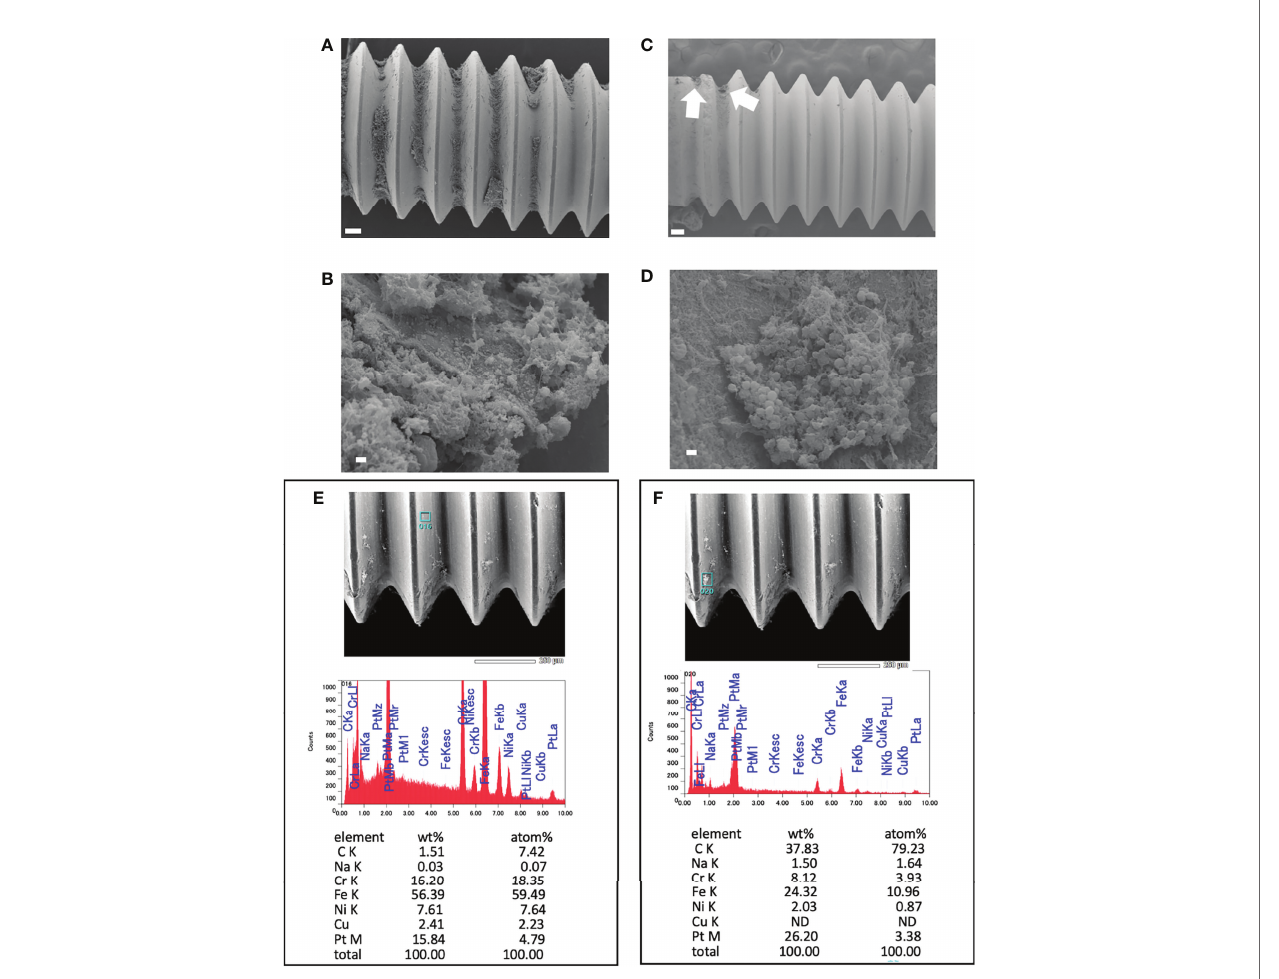
FIGURE 4 | Scanning electron microscopy (SEM) image of USA300LAC infected implant of day 14 in vivo bio fi lm. (A, B) are images after 24 h of antibiotics treatment with 512 µg/mL gentamicin which showed robust bio fi lm formation in the screw grooves. (C, D) are images after vortex-sonication-vortex method (VSVM) which has a fare less bio fi lm compared to before VSVM (A) , but a small amount of residual bio fi lm was observed (white arrows) which has live bacteria (D) in the matrix. Energy Dispersive X-Ray Spectroscopy (EDS) on the implant surface (E) and on the residual bio fi lm (F) after VSVM was shown with the percentage of containing elements. White bars in A and C indicate 100 m m, and white bars in B and D indicate 1 m